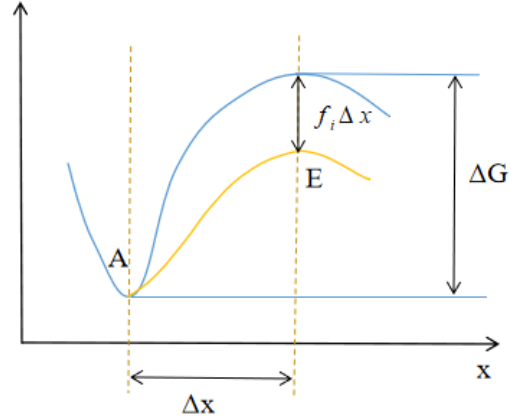
Figure 10. Schematic diagram to show the energy profile of the chemical reaction kinetics.